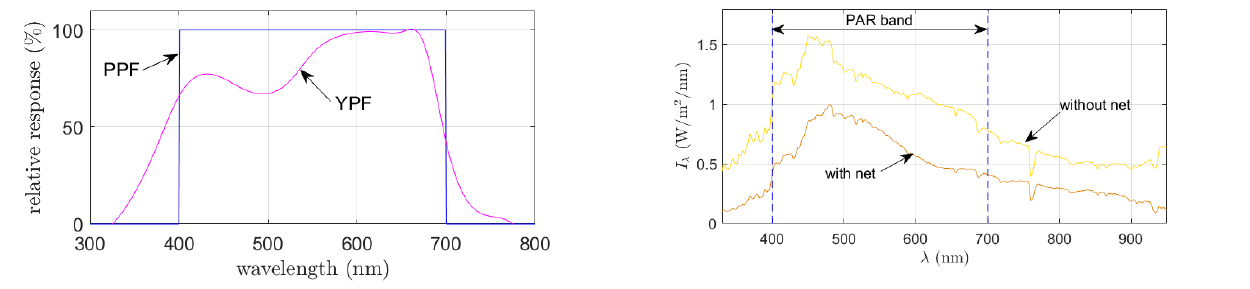
Fig. 3. Relative responses of PPF and YPF PAR.